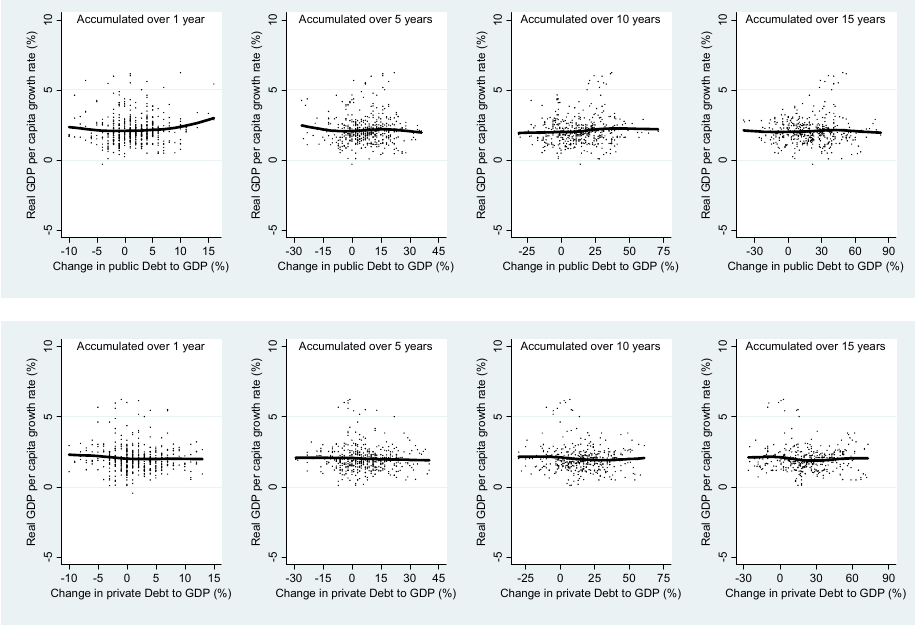
Figure 15 - Growth performance over 15 years with debt accumulation over 1-15 year (h=15 and d=1,5,10,15) – Public & private